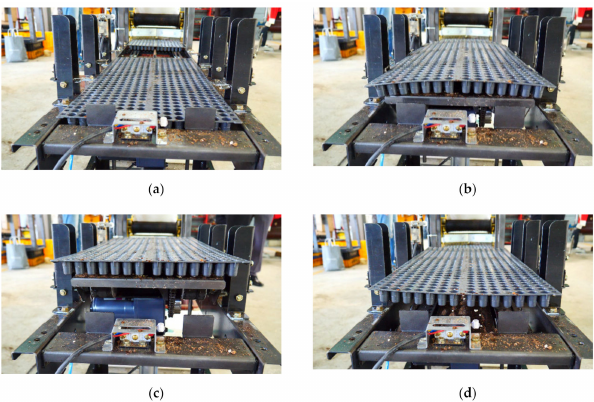
Figure 12. Operating process of automatic accumulating system: ( a ) start of operation → ( b ) ascending of elevator plate by pneumatic-type actuator → ( c ) maximum height of elevator plate (maximum stroke of actuator) → ( d ) descent of elevator plate (return of actuator stroke) and pot tray accumulating on bracket.